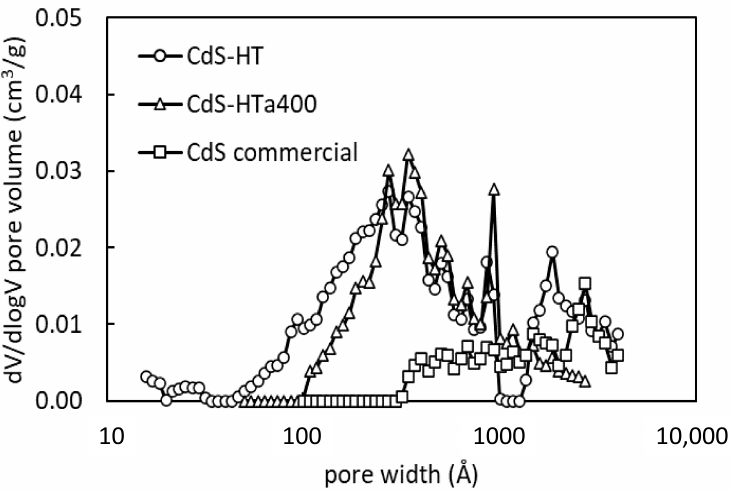
Figure 4. Pore size distribution curves of CdS-HT (circles), CdS-HTa400 (triangles) and commercial CdS (squares). The logarithmic scale allows evidencing better the large pore region.